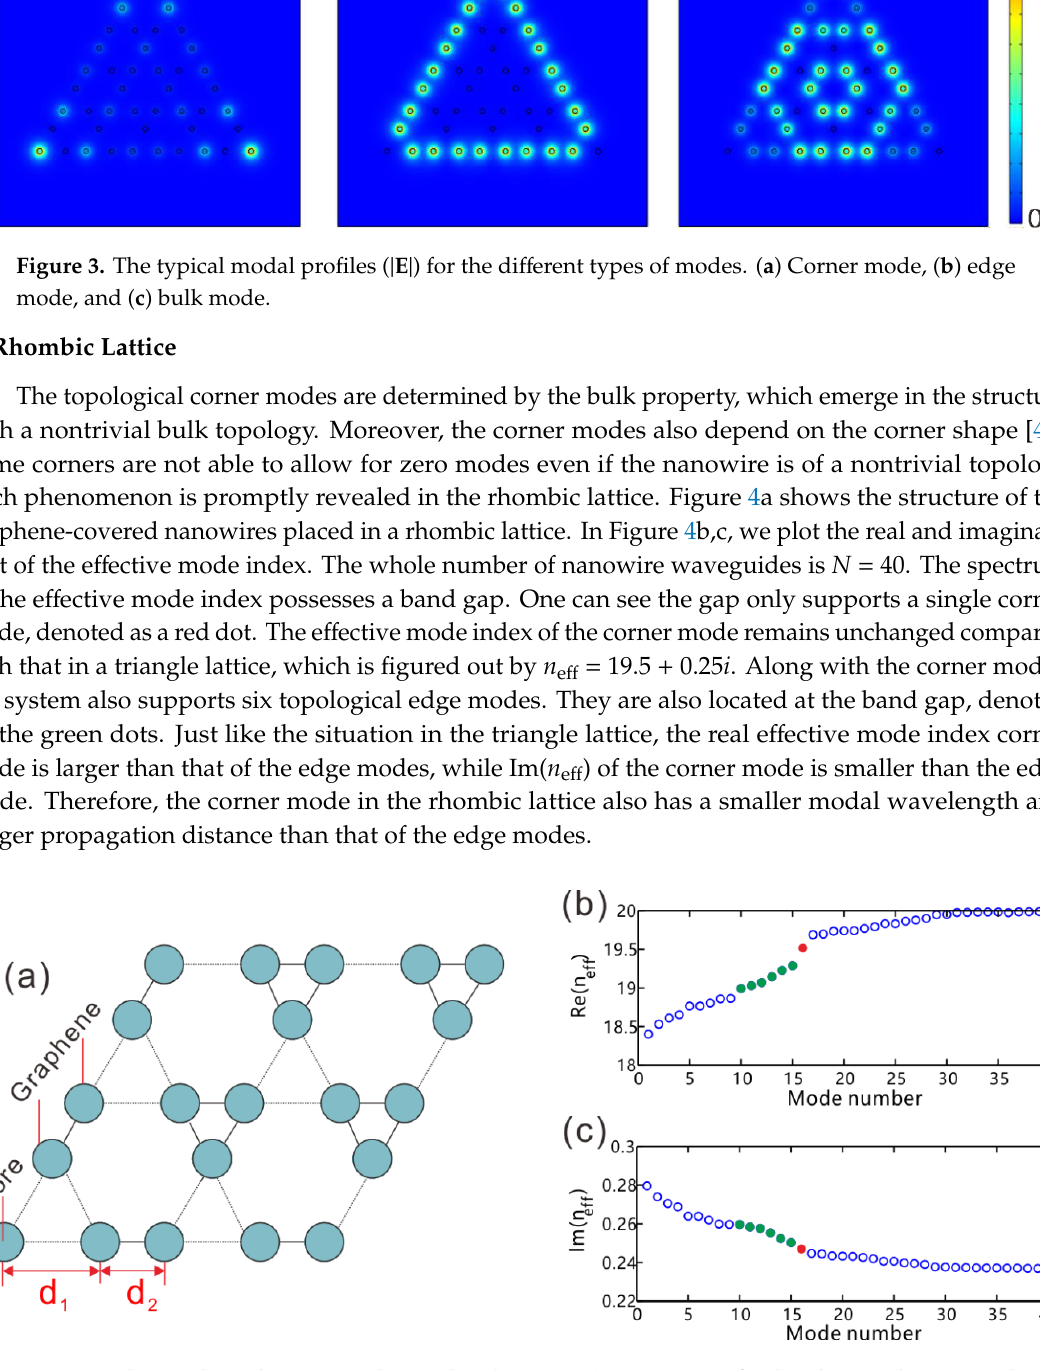
Figure 4. The topological corner mode in a rhombic array. ( a ) Geometry of a rhombic graphene-coated cylinder waveguide. ( b , c ) demonstrate the real and imaginary mode index for d 1 = 400 nm and d 2 = 320 nm.